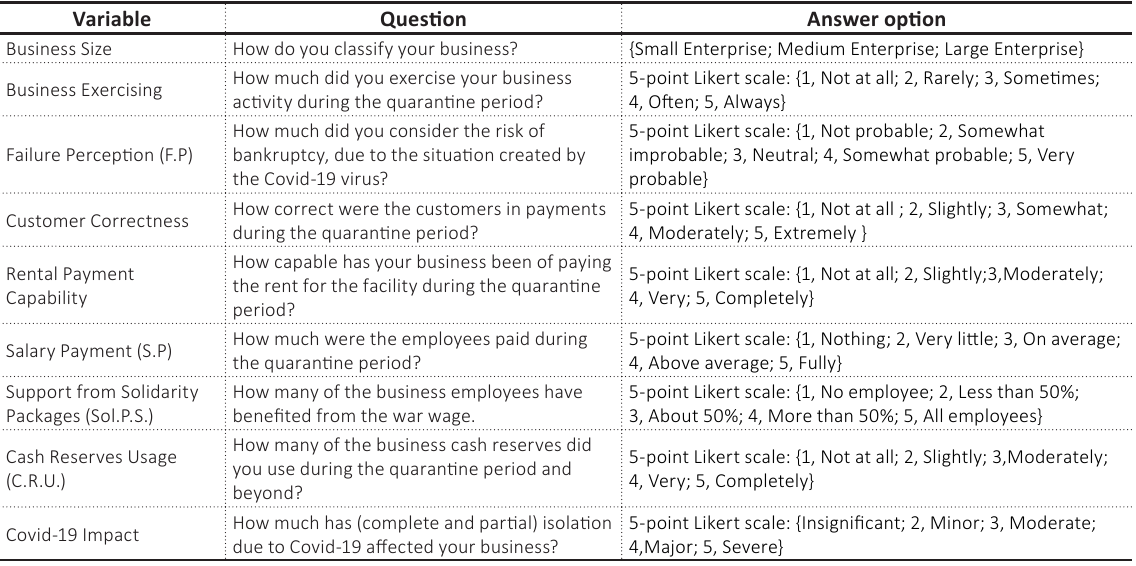
Table 1. Variables, respective questions in the questionnaire and answers with their ordinal values Variable